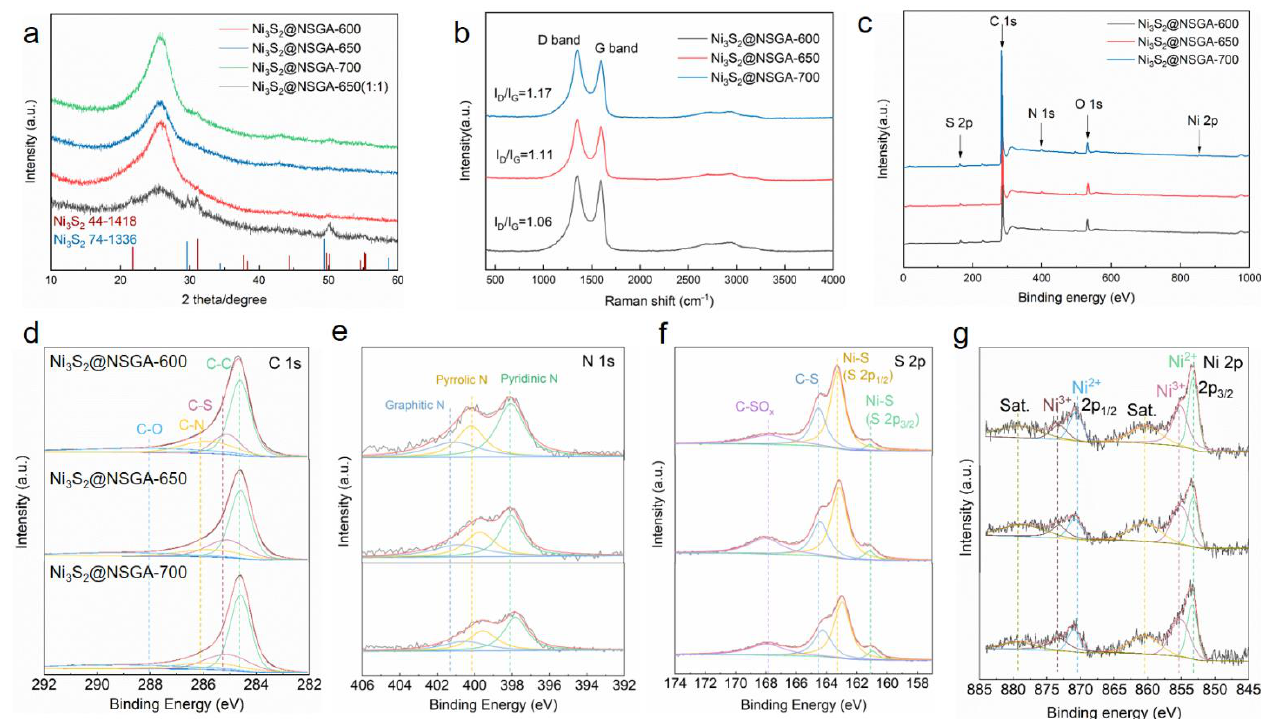
Figure 3. ( a ) XRD patterns, ( b ) Raman spectra, ( c ) XPS survey and high-resolution XPS spectra of ( d ) C 1s, ( e ) N 1s, ( f ) S 2p, ( g ) Ni 2p of as-prepared Ni 3 S 2 @NSGAs. ( d ) C 1s, ( e ) N 1s, ( f ) S 2p, ( g ) Ni 2p of as-prepared Ni 3 S 2